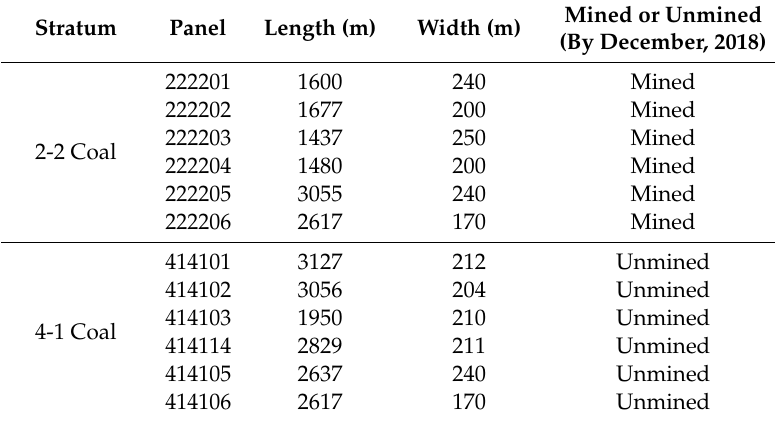
Figure 4. The layout of panels in Yangjiacun Coal Mine and monitoring lines in numerical simulation (line M1 to line M6). Points a, b, c, and d are the boundary points of panel No. 222201. The GPS subsidence monitoring points (as shown in Figure 5) are located on the surface above panel No. 222201. Table 1. The dimensions of panels in Yangjiacun Coal Mine.